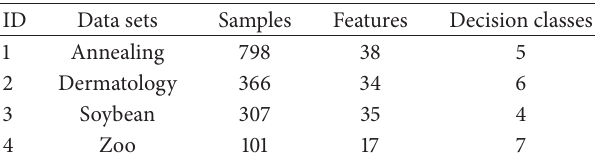
Table 1: Data sets